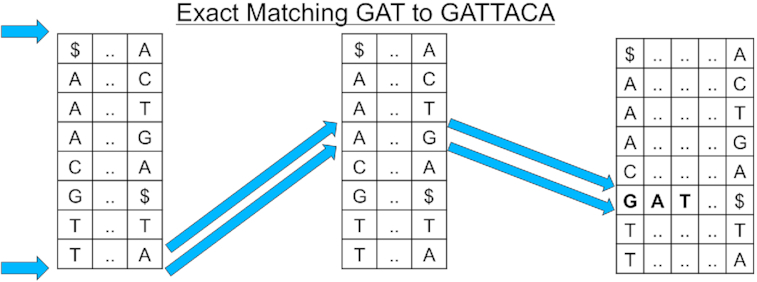
A diagram showing the exact match algorithm by repeated application of the last-first property using the characters of the query string.